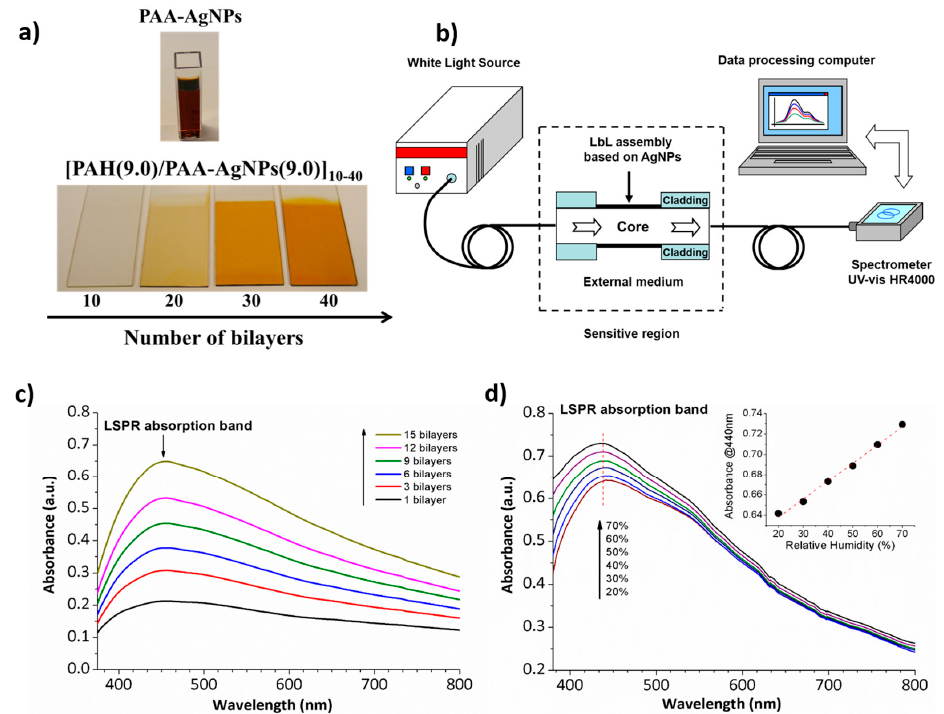
Figure 10. ( a ) Photograph of the PAA-AgNPs with an orange coloration and their incorporation into thin films by using the Layer-by-Layer assembly; ( b ) Experimental setup used to obtain and characterize the LSPR in the visible region; ( c ) UV-Vis spectra of the LbL coatings based on the incorporation of the AgNPs as a function of the thickness coating from 1 to 15 bilayers; ( d ) Spectral response of the LSPR-optical fiber sensor to RH changes from 20% to 70% RH. Reprinted with permission of [65].